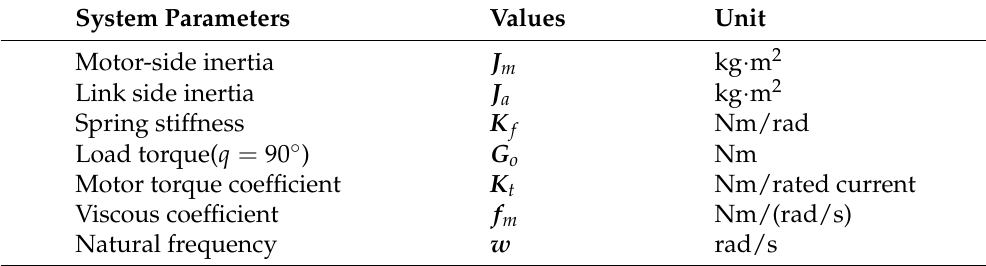
Figure 12. The flexible robot system experimental setup. Table 1. SEA system